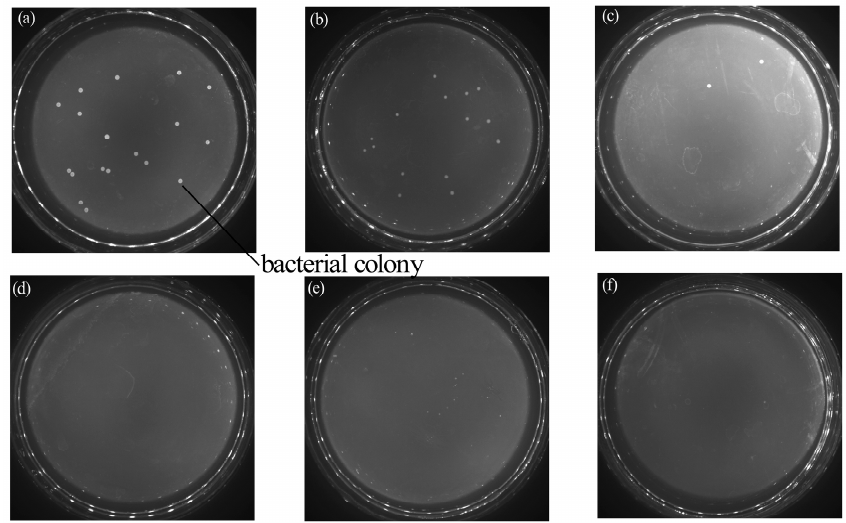
Figure 6. Media photos that correspond to the sample membranes with antibacterial properties under different sputtering times. ( a ) Blank control group; ( b ) virgin membranes; ( c ) 5 min; ( d ) 15 min; ( e ) 30 min; and ( f ) 45 min.